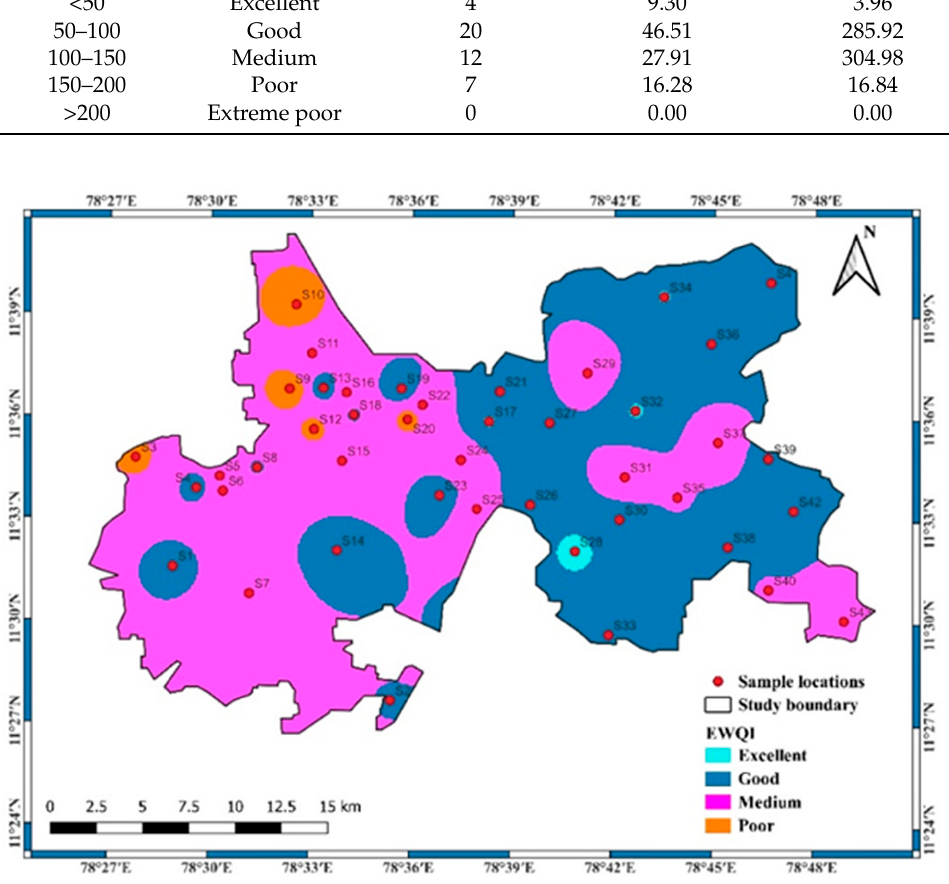
Figure 5. Irrigation indices methodology.